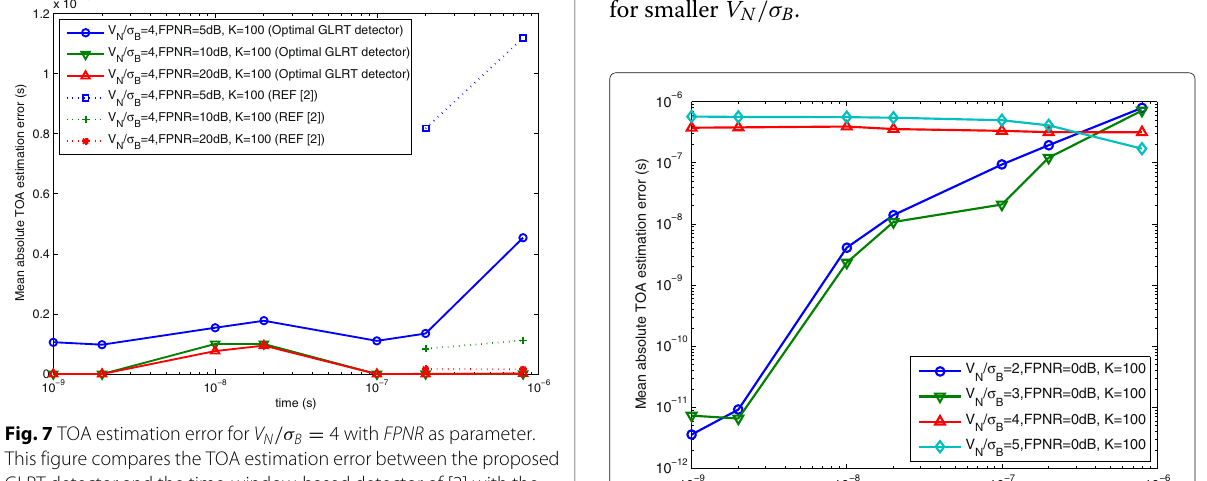
measurements, a pulse cannot be detected when it arrives within this 160 ns window. The improved performance of the proposed technique is because it is an MLE scheme based on the PDFs of the measured data, rather than a time-window-oriented detection scheme, which better exploits the available information of the measurement data. But this comes at the expense of a higher compu- tational cost. Moreover, the proposed scheme could work under a wider range of V N /σ B and FPNR under specific conditions (e.g., specific range of t r ), as shown in Figs. 8 and 9, which is not applicable for the scheme in [2]. Figure 8 shows the performance of the proposed scheme for lower values of V N /σ B . For the cases of V N /σ B = 2 and 3, it is observed that the TOA estimation error increases with increasing t r . This is due to the fact that P EFA increases and and P D decreases with increasing t r as shown in Fig. 5a, b, respectively. Also, P D decreases faster for smaller V N /σ B .